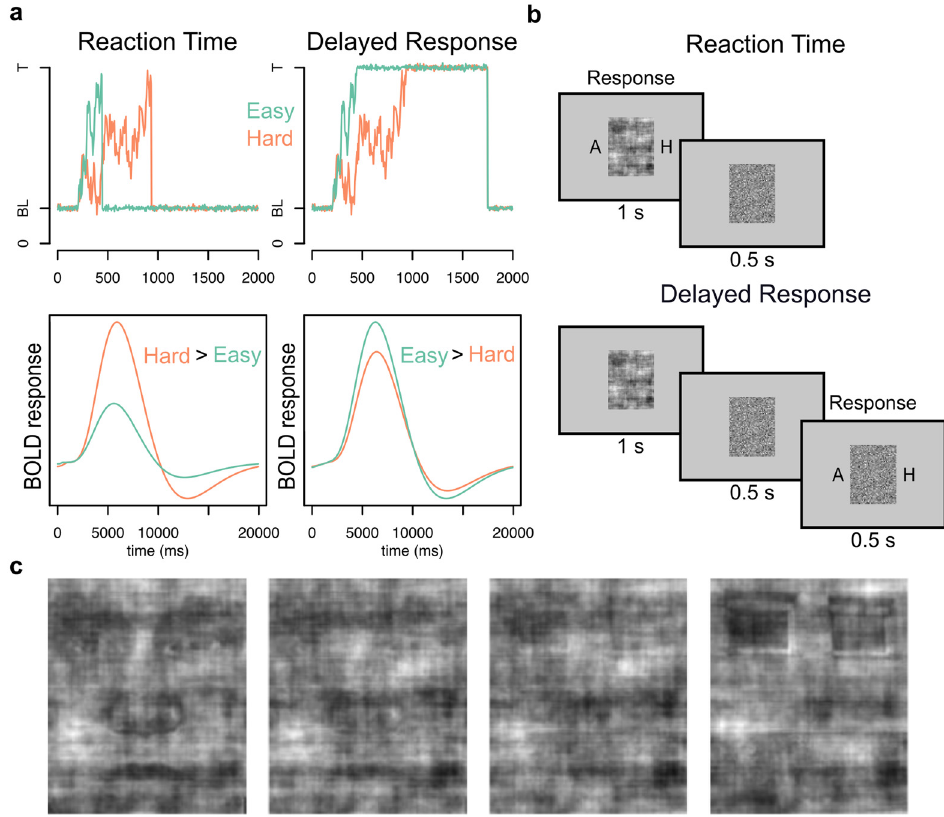
Fig 1. Blood oxygenation level dependent (BOLD) response predictions, experimental task and stimuli. (A) Predictions of BOLD-response of accumulator area. The top figures displays simulated firing rate from baseline (BL) to decision threshold (T) of neurons in lateral intraparietal area in monkeys during reaction time (left) and delayed response (right) conditions for easy (green) and hard (orange) choices. The bottom two figures in (A) display expected BOLD response for these conditions, which were estimated by convolving the simulated firing rate with the canonical hemodynamic response function (HRF). (B) Task paradigm. Responses were given while viewing stimuli in the reaction time condition (top), while after a forced delay in the delayed response-condition. The presentation of the letters “ A ” and “ H ” (representing the words face ( “ Ansikt ” ) and house ( “ Hus ” ) in Norwegian) informed participants that a response could be given. (C) Images of faces and houses were divided in the following categories depending on level of phase coherence and stimulus type (from left): easy face, hard face, hard house and easy